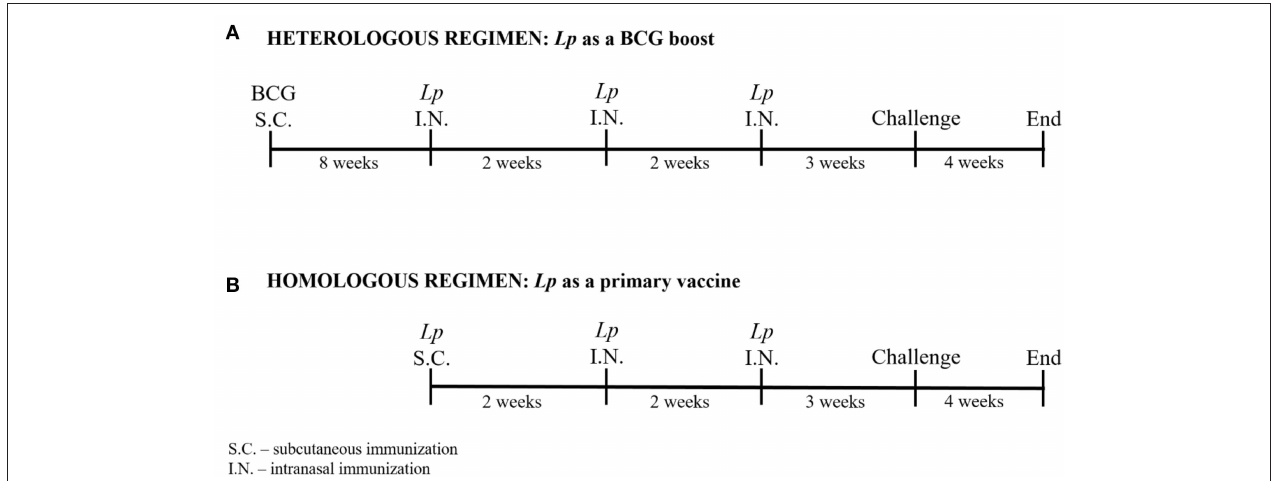
FIGURE 2 | Immunization protocols. Two prime-boost immunization strategies were applied: a heterologous regimen including parenteral BCG immunization followed by three intranasal Lp boosts (A) , and a homologous regimen including parenteral Lp immunization followed by two intranasal boosts (B) . Mice were challenged with M. tuberculosis via aerosol delivery 3 weeks after the last vaccination. The experiment was terminated 4 weeks after mycobacterial infection.